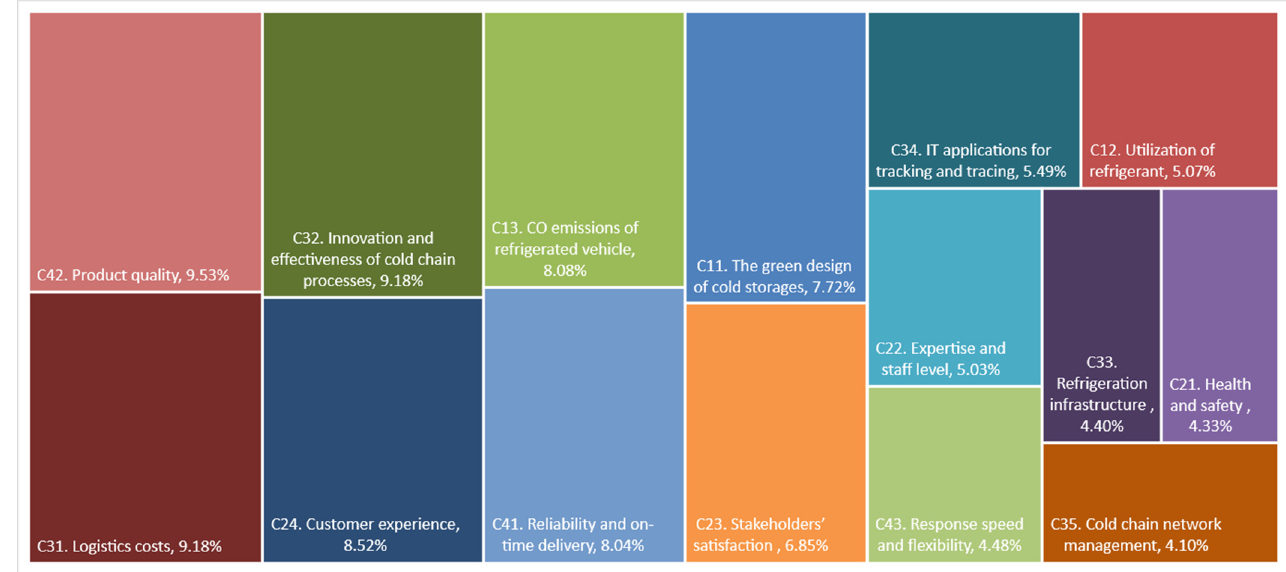
Figure 4. The significance level of criteria from the G-AHP.